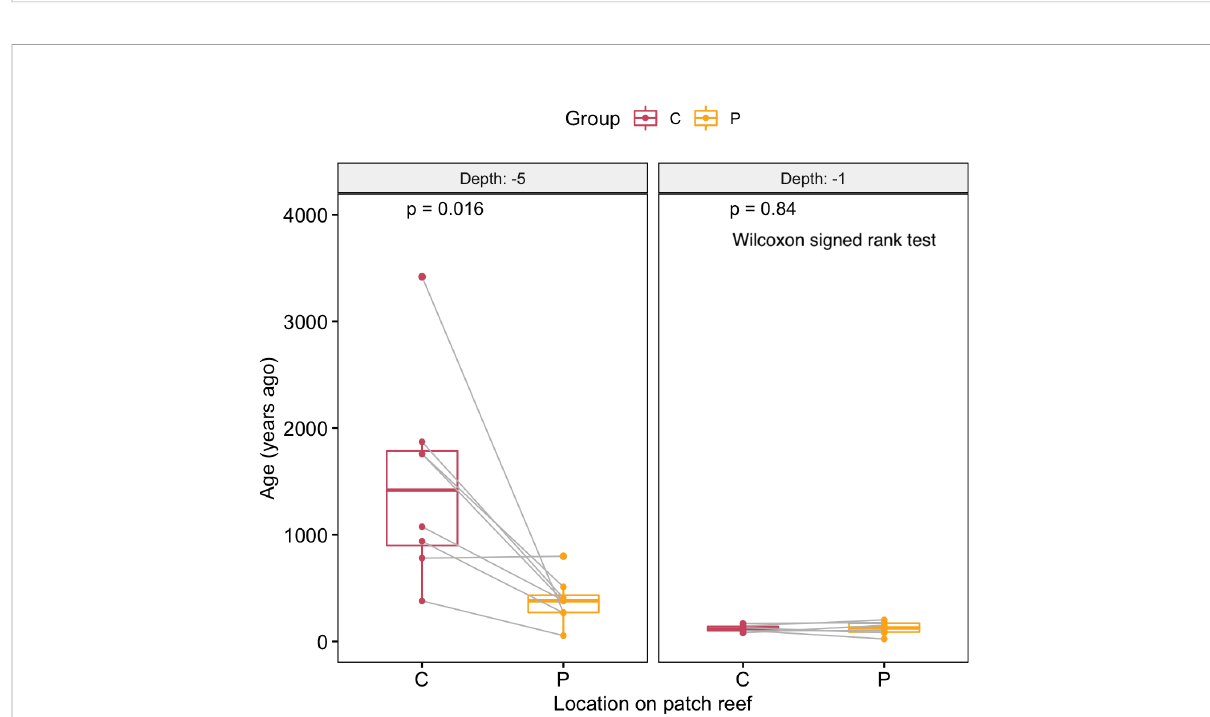
FIGURE 8 Age comparison of the centers and peripheries of fl at-top patch reefs. The centers of the surfaces of the fl at-top patch reefs at − 5 m were older than their peripheries; this trend was not observed among the reefs at − 1 m. A signi fi cant difference was identi fi ed between the reefs at depths of − 5 m and − 1 m. Paired comparisons of the ages in different parts of patch reefs in two depths, respectively. C: Center, P: Periphery, of a patch